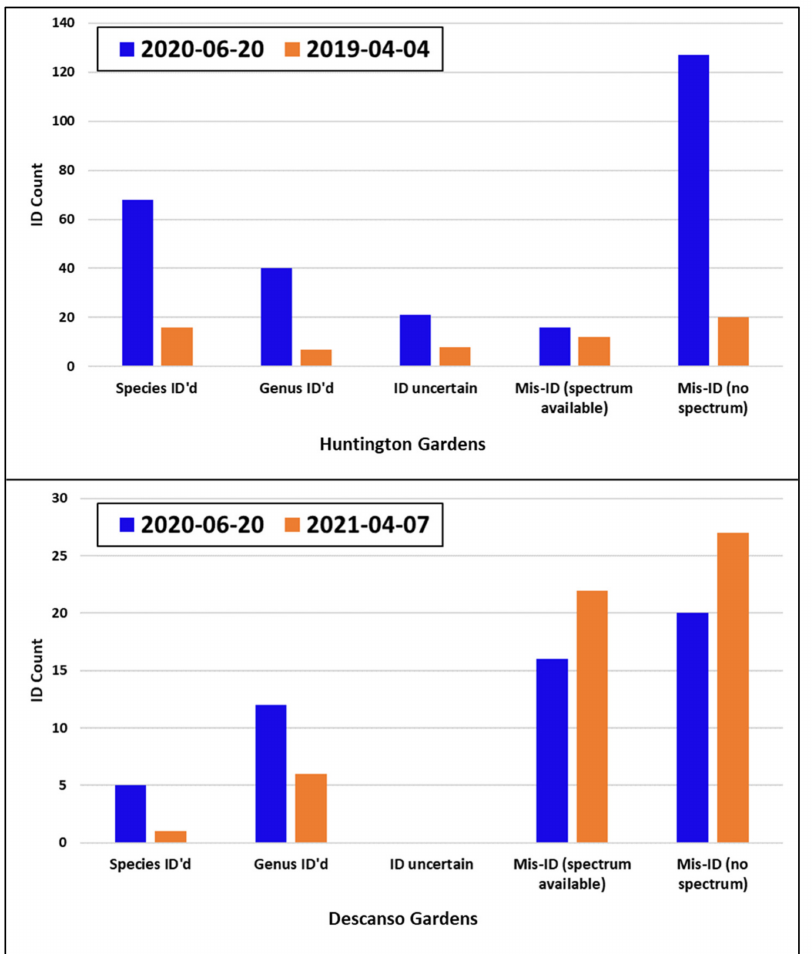
Figure 24. Comparison of spring and summer ID statistics for the Huntington Gardens and Des- canso